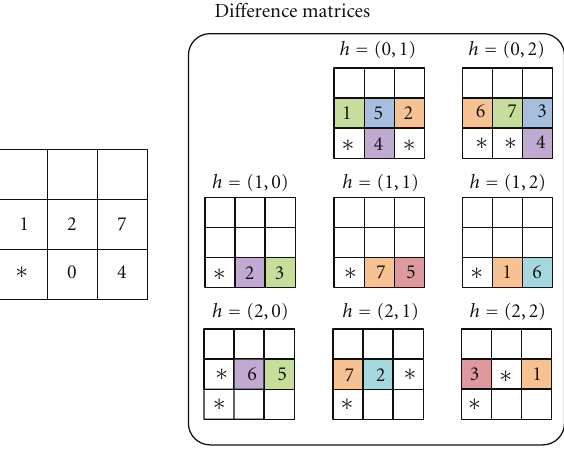
Figure 4: Di ff erence matrices for a subpermutation during enu- meration of Z 3 × Z 3 MPCAs, to illustrate the behavior of h and − h matrix